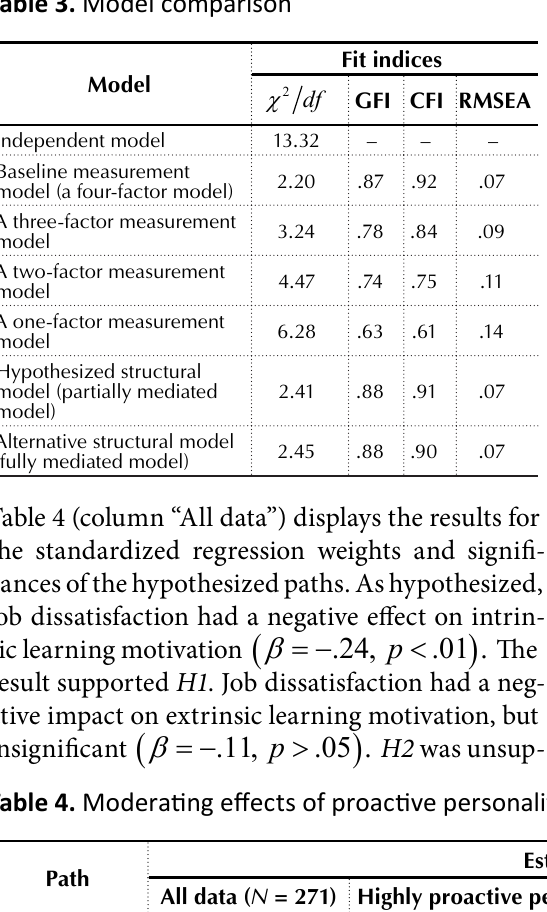
Table 3. Model comparison